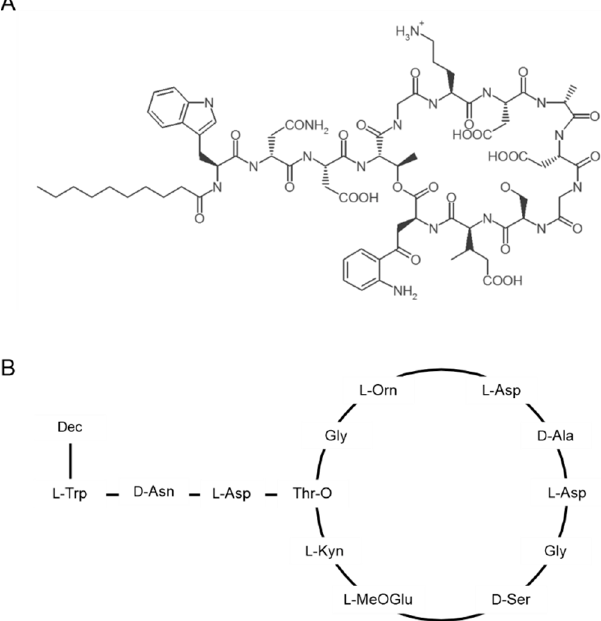
Figure 1. Structure of daptomycin. ( A ) Chemical structure. ( B ) Amino acid sequence. Dec: decanoyl chain, L-Orn: L-ornithine, L-MeOGlu: L-methylglutamic acid, L-Kyn: L-kynurenine .